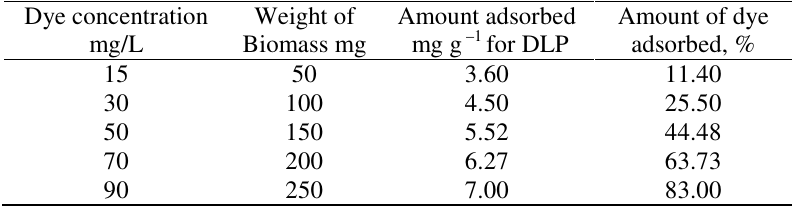
Table 2. Amount of Grey BL adsorbed on Derris leaf powder at 300 K in mg g -1 Dye concentration Weight of Amount adsorbed mg/L Biomass mg mg g –1 for